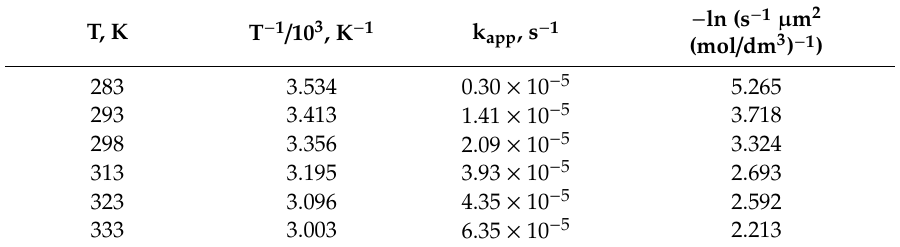
Figure 16. Converter slag leaching kinetics for di ff erent particle sizes.